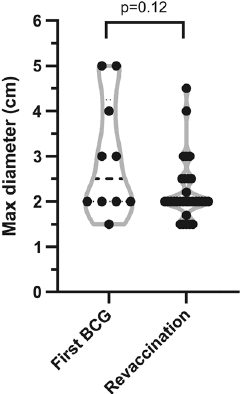
Fig. 3 Injection site abscess size. Maximum diameter of injection site